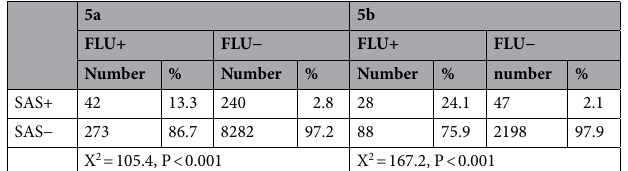
Variables Coeff z value OR Going out without face mask 1.95 Excessive exercise before going to bed 0.74 Falling asleep while sitting or talking with